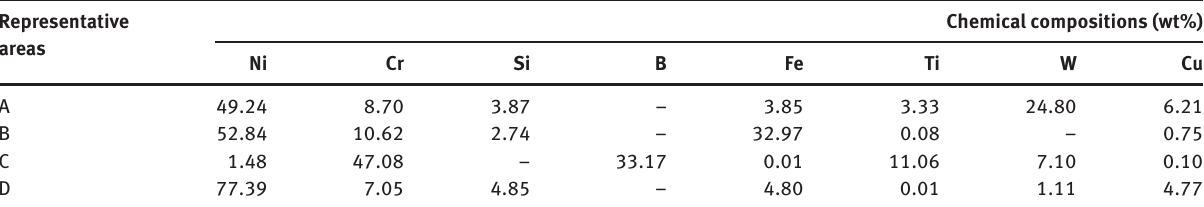
Table 3: Chemical compositions of representative areas of NiCrSiBFeTi brazing seam region. Representative areas